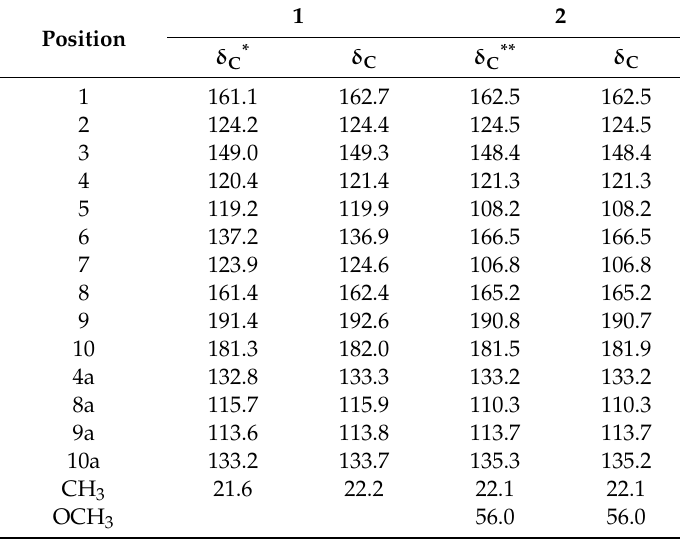
Table 2. 13 C-NMR data for compounds 1 and 2.